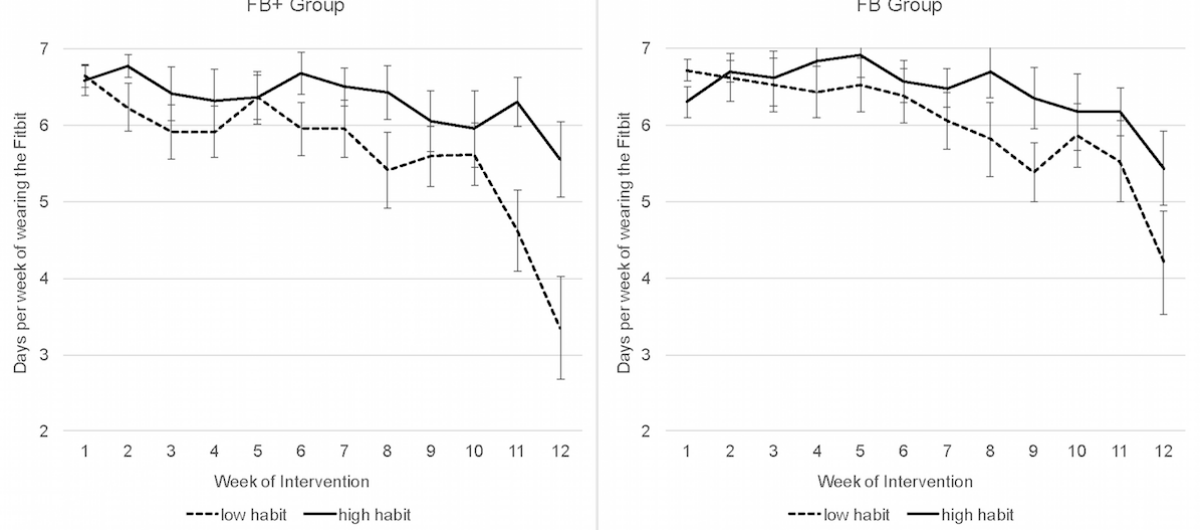
Figure 4. Fitbit wear time in relation to habit automaticity over the intervention period by the group (FB+, FB). High versus low habit was defined using a median split of the data. FB+: Fitbit with motivational interviewing; FB: Fitbit